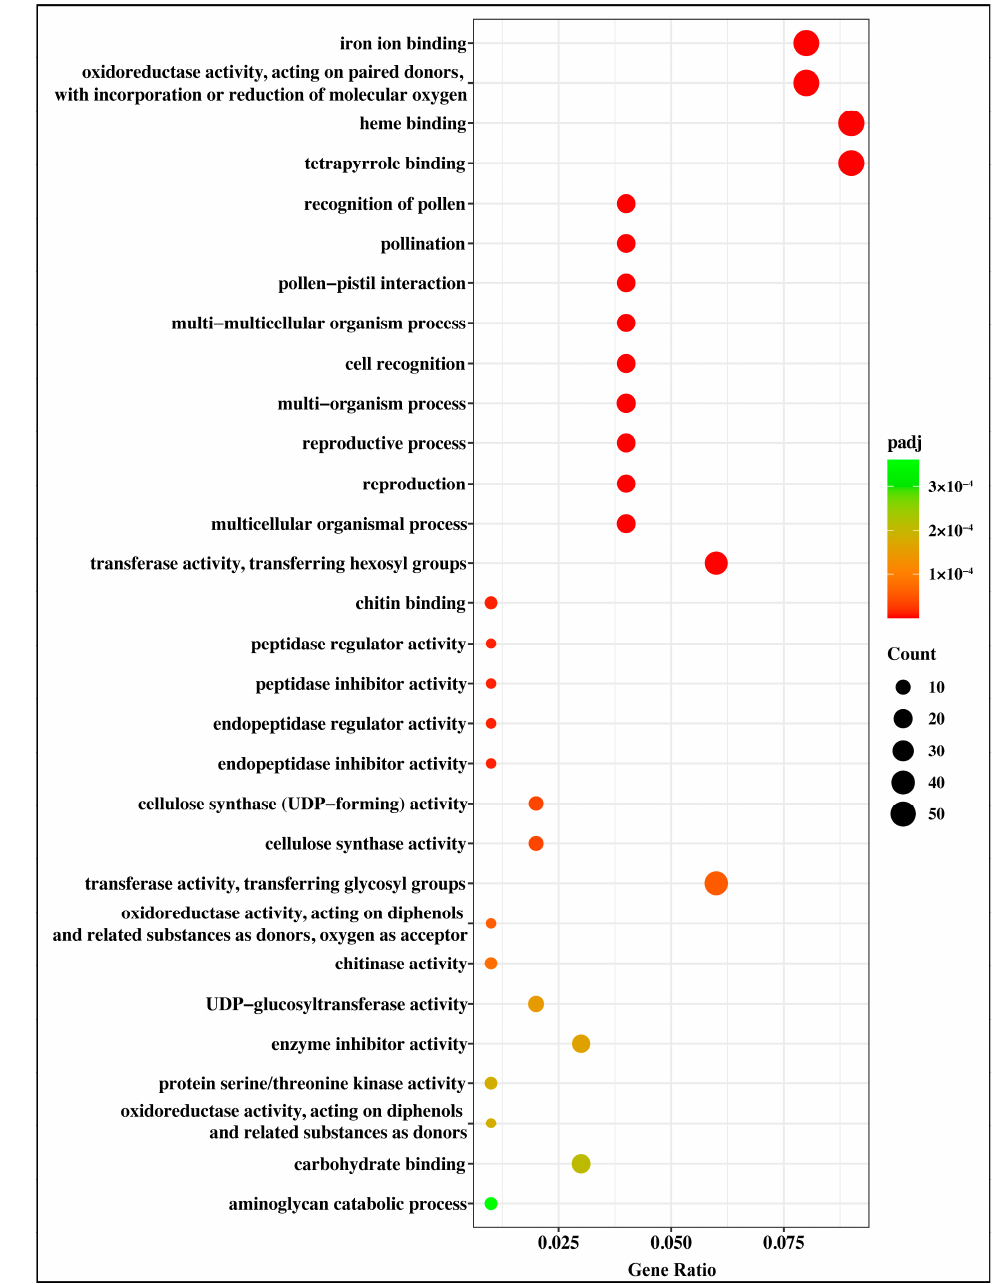
Figure 11. Gene ontology (GO) enrichment for drought ‐ responsive tandemly repeated genes in G. anomalum . The closer to red, the more the differential genes contained under each function are represented by the size of the dots.